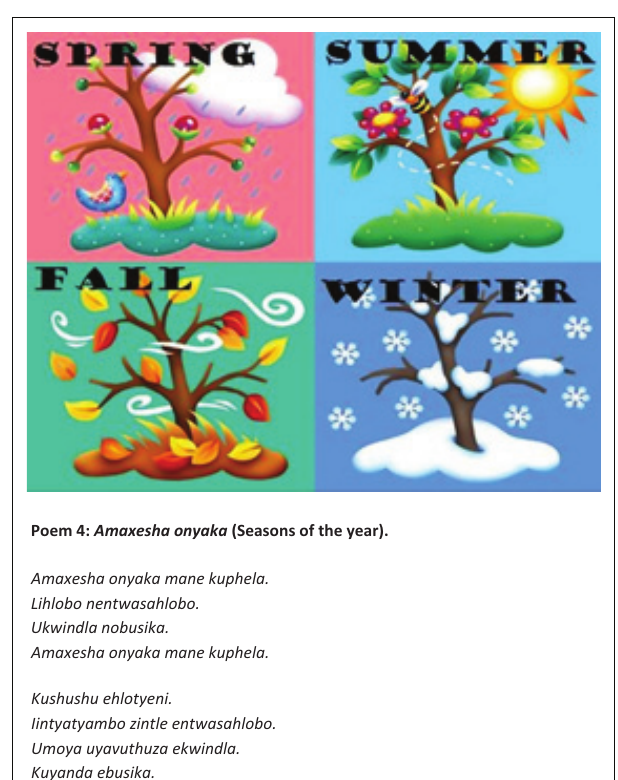
FIGURE 4: Different seasons of the